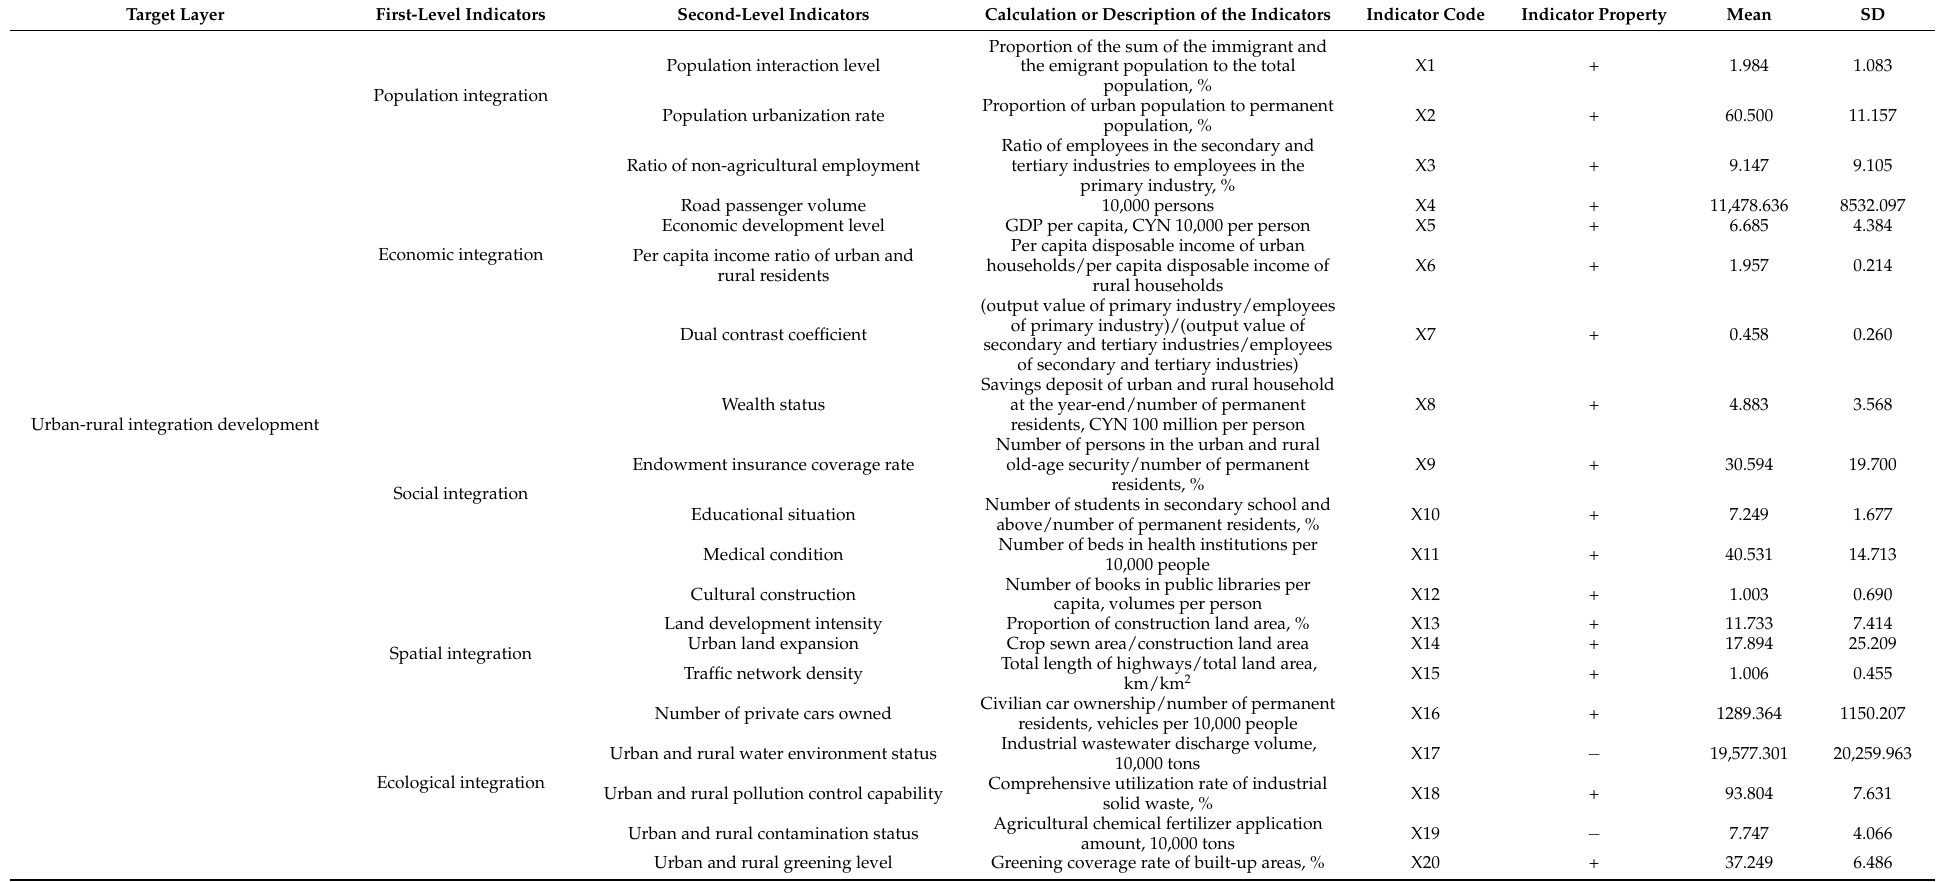
Table 1. The measurement indicator system of URID and the summary statistics of